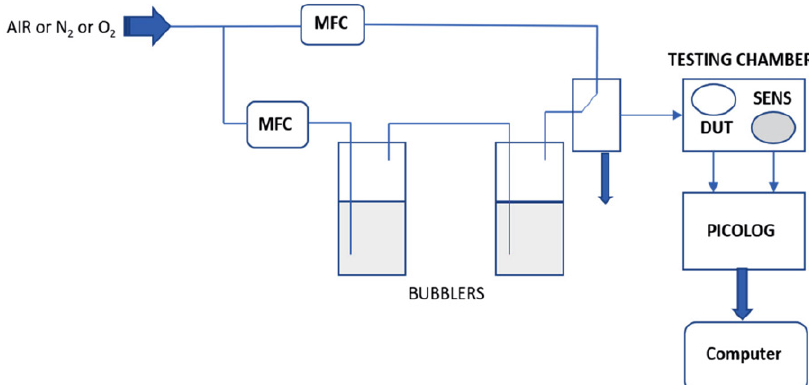
Figure 1. Experimental set-up employed for RH measurements.